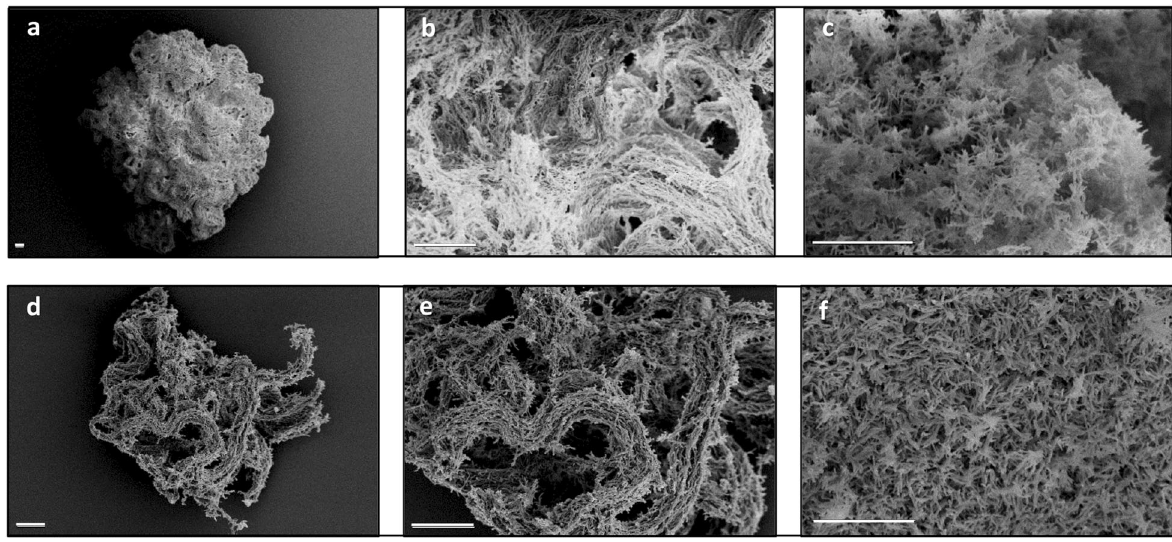
Fig. 2 Bio fi lm macrostructure reveals densely packed bacilli looped into corded structures. Scanning electron microscopy of a – c RCCS- bio fi lm and d – f . non-rotating M. bovis BCG control. RCCS-bio fi lm shows more compact growth with enriched topology and higher deposition of extracellular matrix. Scale bar is 20 µM in all